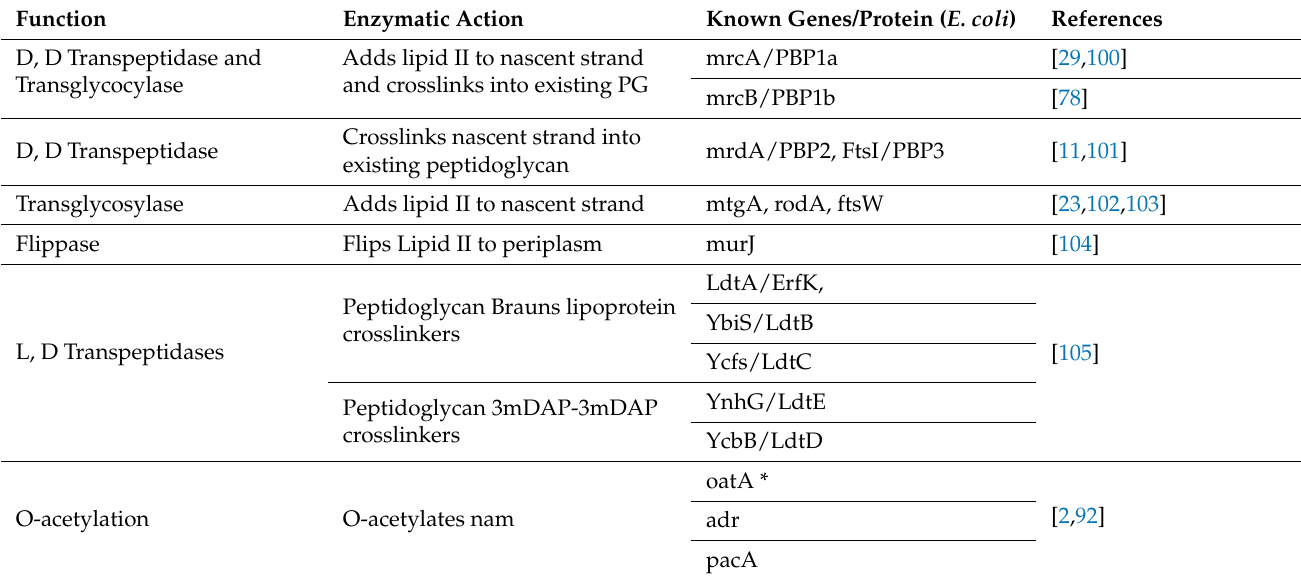
Table A2. Characterised peptidoglycan synthases in Gram-negative